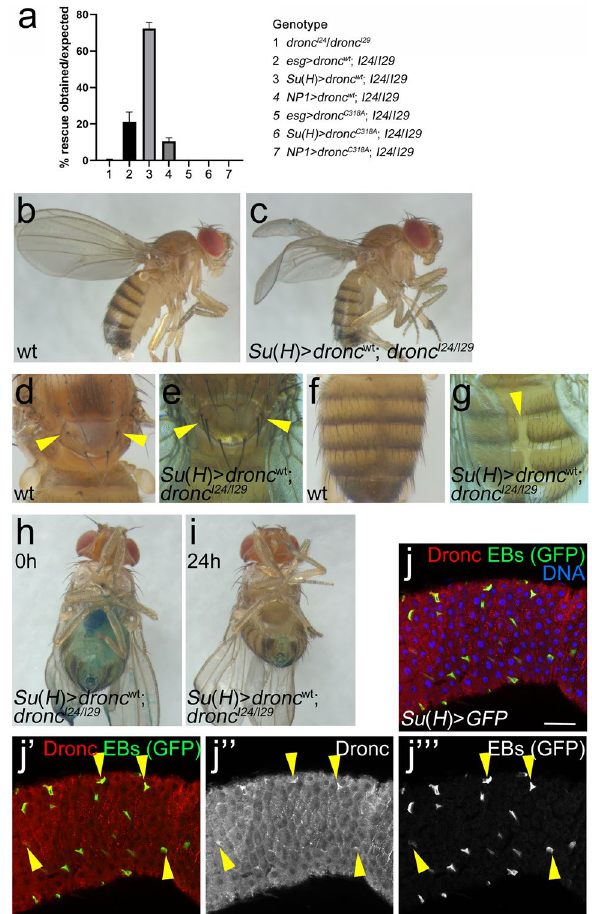
Figure 2. Enteroblast-specific expression of dronc wt rescues the semi-lethality and leakage of homozygous dronc mutant animals. ( a ) esg-Gal4 (expression in ISCs), Su(H)-Gal4 (EBs) and NP1-Gal4 (ECs) were used to drive expression of UAS - dronc wt or UAS - dronc C318A in dronc I24 / dronc I29 ( I24 / I29 ) mutants and survival was scored. dronc C318A carries a mutation of the catalytic Cys318 residue to an Ala and represents a catalytic mutant. dronc I24 / dronc I29 (genotype 1) is strongly pupal semi-lethal and less than 1% of the expected progeny can be recovered as adults. The obtained progeny in the rescue crosses is plotted as the percentage of the expected Mendelian progeny. Genotypes of expected rescued progeny are indicated on the right. The average of three independent experiments is shown. At least 200 flies were counted in each experiment. Rescue data were analyzed by one-way ANOVA with Holm-Sidak test for multiple comparisons. Error bars are SEM. ( b , c ) While the wings of wild-type (Canton S) flies are straight ( b ), the wings of Su ( H ) > dronc wt ; dronc I24 /dronc I29 rescued flies are down-curved ( c ) similar to dronc I24 /dronc I29 mutants 11 . (d-g) Su ( H ) > dronc wt ; dronc I24 /dronc I29 flies exhibit morphological phenotypes. Canton S (wt) flies contain 4 scutellar bristles (macrochaetae) ( d ) and have a closed abdomen ( f ). All Su ( H ) > dronc wt ; dronc I24 /dronc I29 rescued flies have duplications of 1 or 2 macrochaetae ( d , arrowheads) and about 50% display a split abdomen phenotype ( g , arrowhead) (n > 50). ( h , i ) 25 out of 26 tested Su ( H ) > dronc wt ; dronc I24 /dronc I29 show a wild-type SMURF phenotype ( h ) (compare to Fig. 1d,e). 24 h after removal from blue food, these flies have completely cleared the gut of blue food ( i ). ( j ) Labeling of Su ( H ) > GFP midguts with anti-Dronc antibodies (red in j and j’ ; grey in j’’ ). EBs are labelled by GFP (green in j and j’ ; grey in j’’’ ). Yellow arrows highlight several EBs containing Dronc protein. Scale bar: 50 µm. See also Supplementary Fig.